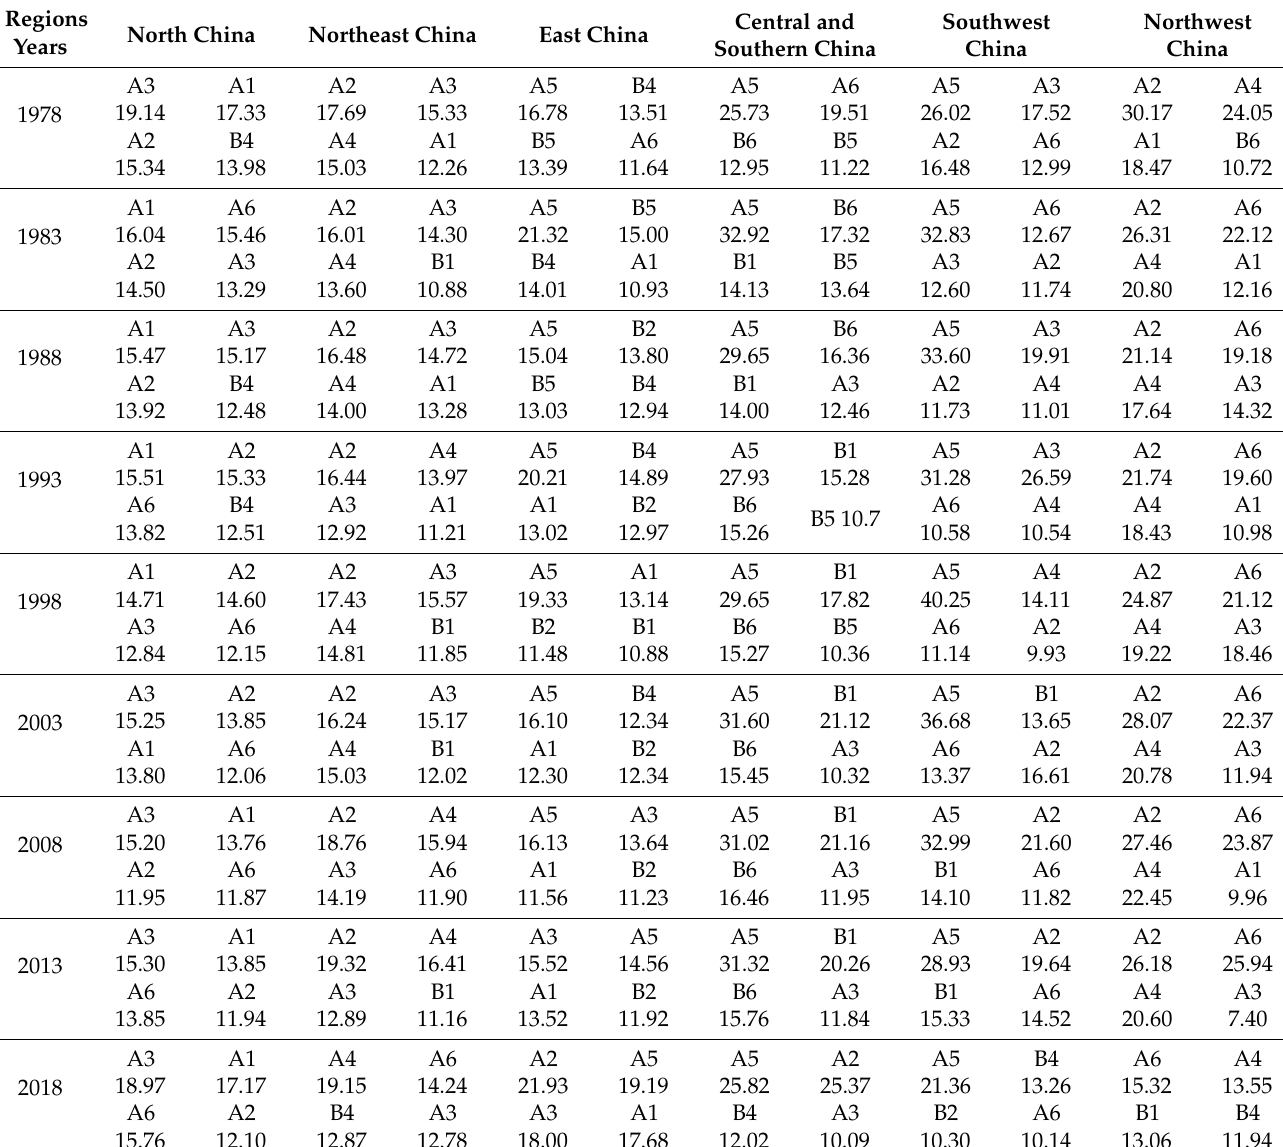
Table 6. The top four indicators and contribution of agricultural drought vulnerability in different regions. Regions North